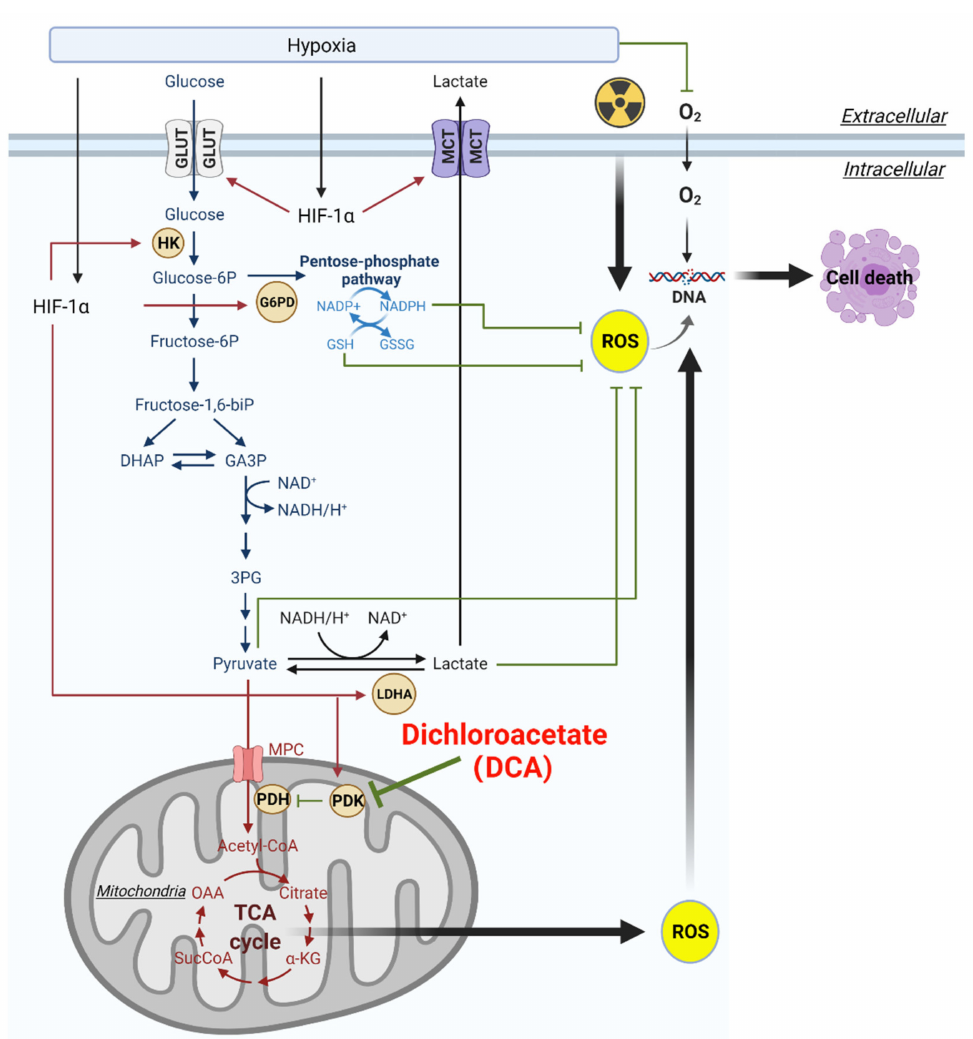
Figure 1. Hypoxia can regulate glycolysis, lactate, and pentose phosphate pathways in radioresis- tance. Dichloroacetate (DCA) has the potential to overcome radioresistance by targeting pyruvate dehydrogenase kinases (PDK). G6PD, glucose-6-phosphate dehydrogenase; GLUT, glucose trans- porters; GSH, glutathione; GSSG, glutathione disulfide; HIF-1, hypoxia inducible factor-1; HK, hexokinase; LDHA, lactate dehydrogenase A; MCT, monocarboxylate transporter; MPC, mitochon- drial pyruvate carrier; PDH, pyruvate dehydrogenase; PDK, pyruvate dehydrogenase kinase; ROS, reactive oxygen species. Figure created with BioRender.com (accessed on 3 June